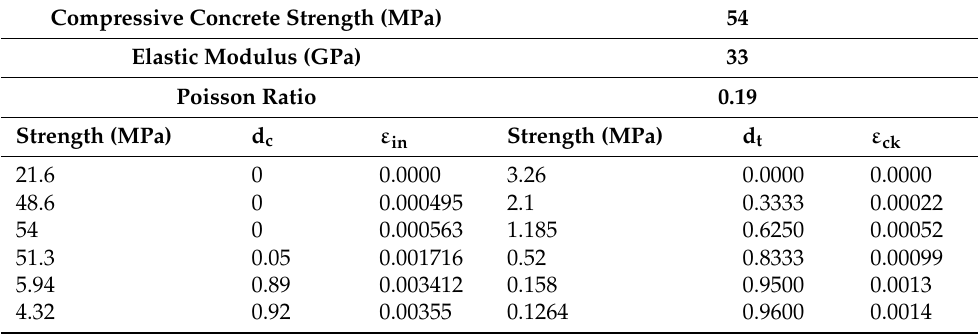
Table 8. Properties of NSC along with CDP model parameters in compression and tension in the flexural test.